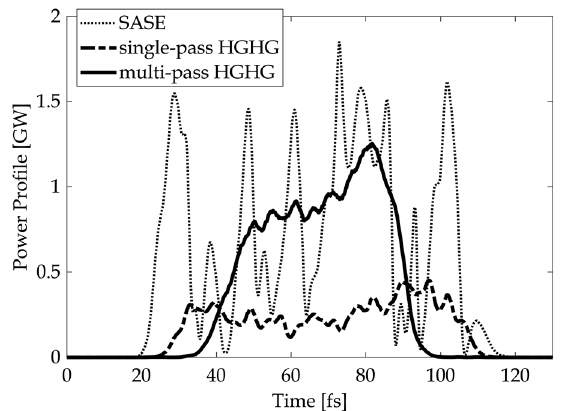
FIG. 13. Output power profile for the three cases with the same electron beam parameters. For the HGHG simulations, this is the 12th harmonic of 50 nm seed laser. For the multipass HGHG, we show the results for the 65th pass.